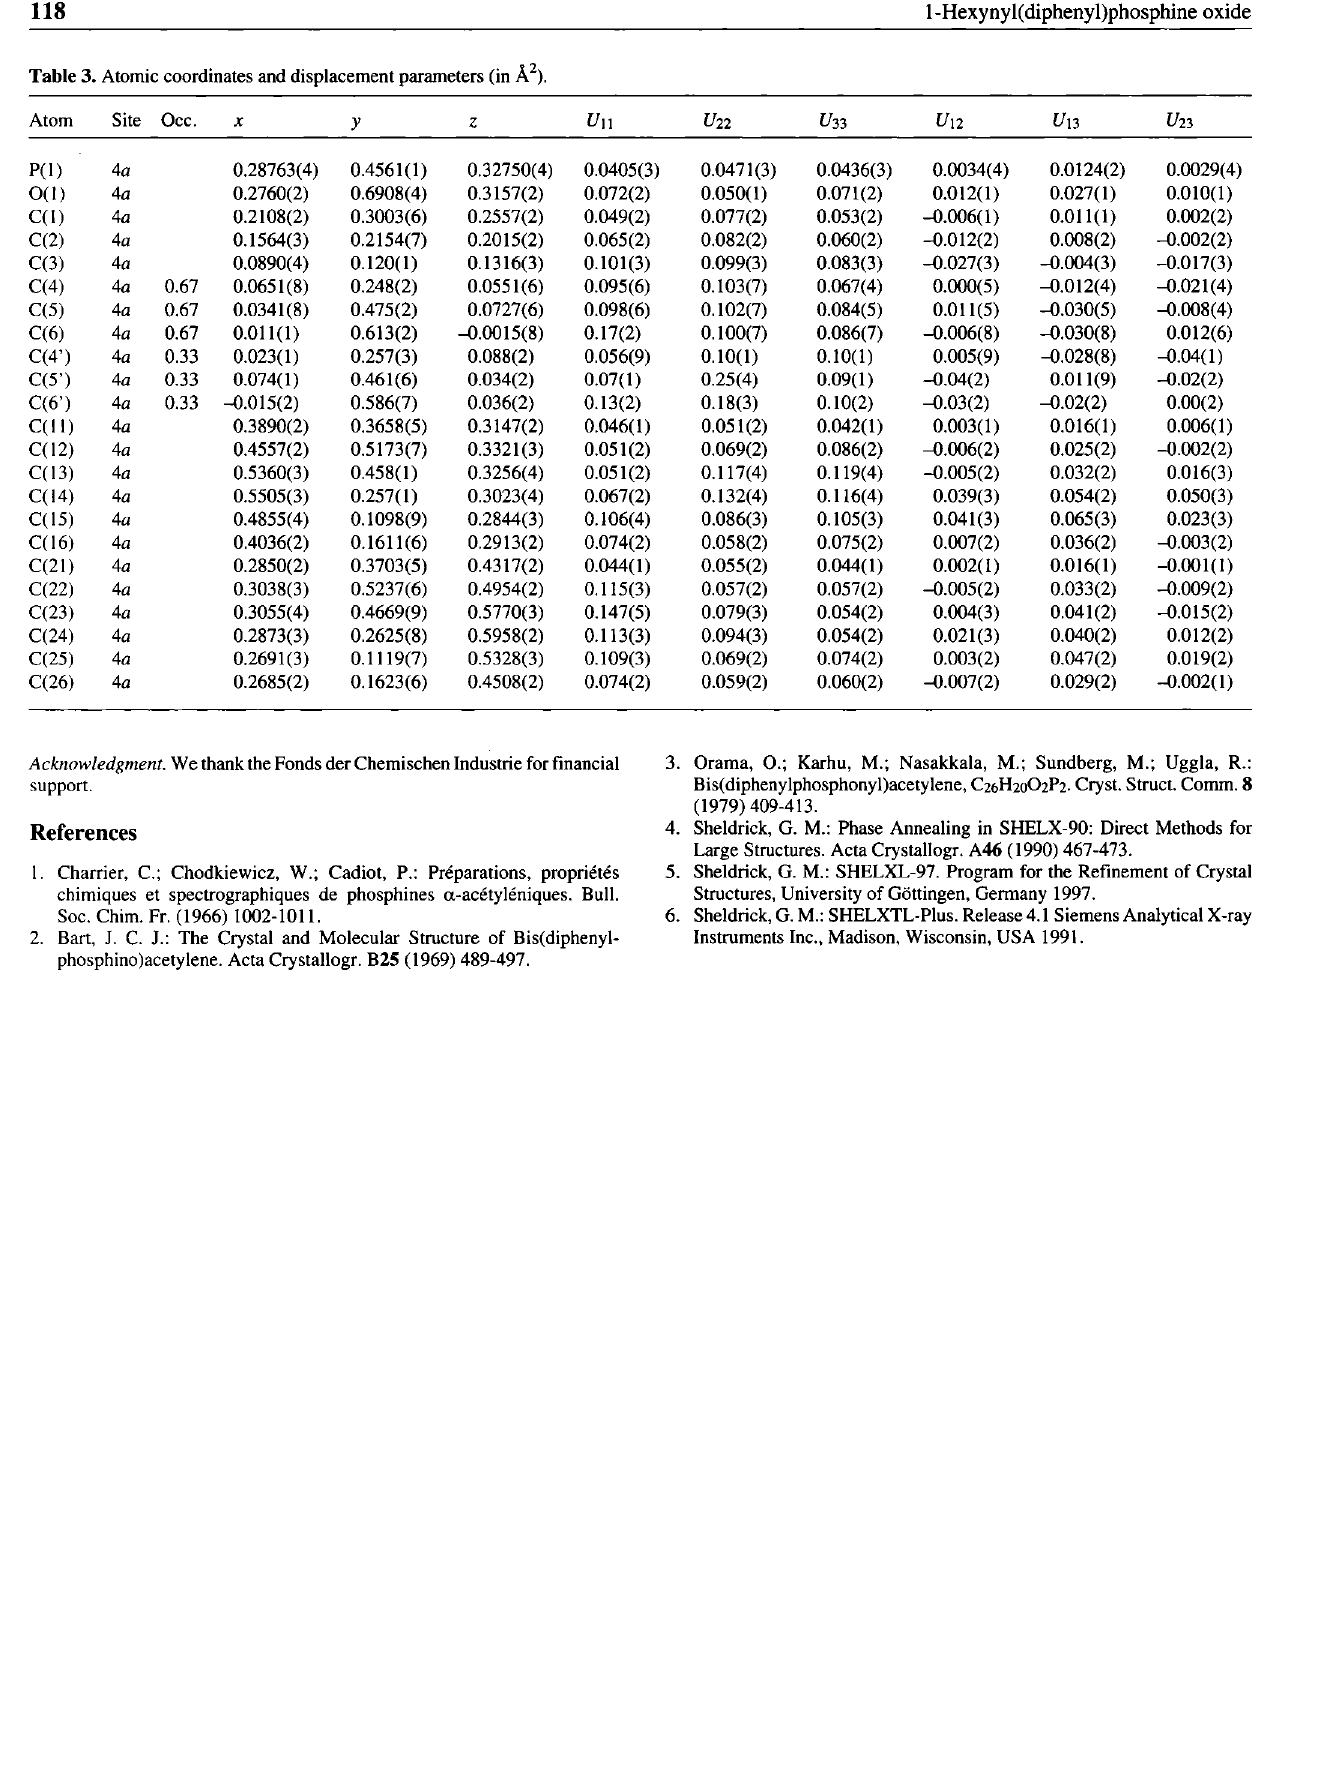
Table 3. Atomic coordinates and displacement parameters (in Ä 2 ). Atom Site